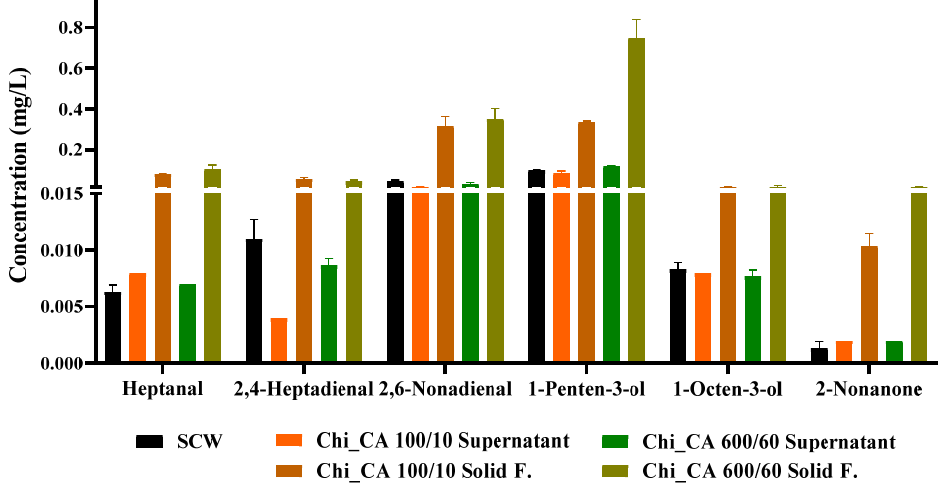
Figure 5. Concentration of the different aromatic markers present in the two fractions obtained by coagulation/flocculation using chitosan/carrageenan. SCW-sardine cooking wastewater. coagulation/flocculation using chitosan/carrageenan. SCW-sardine cooking